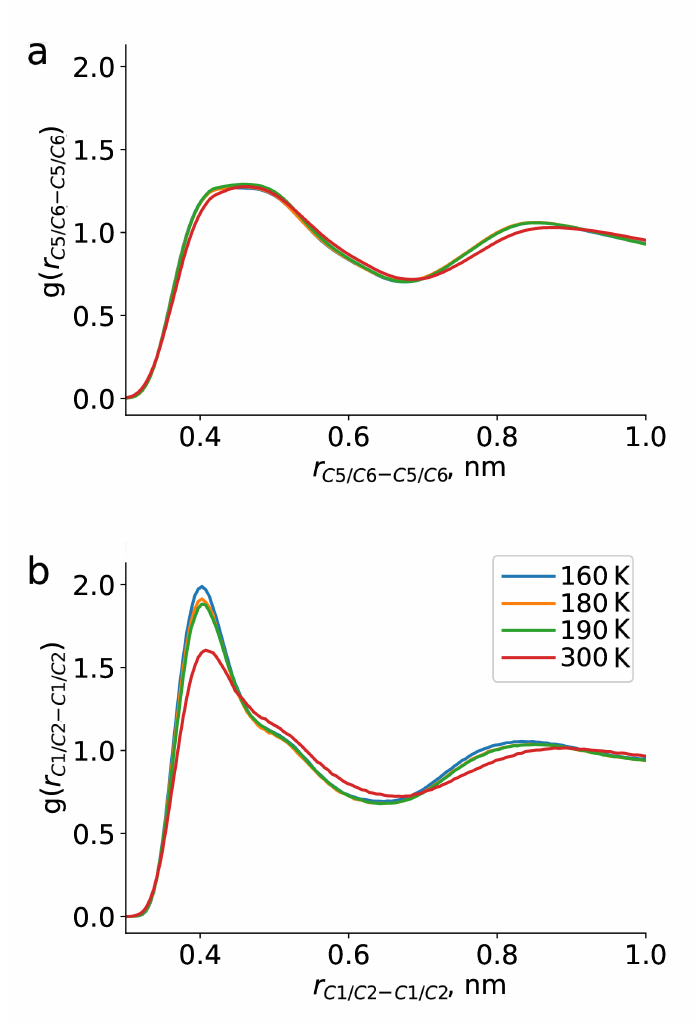
Figure 6. Radial distribution functions for distance between DBP rings (C5 and C6 atoms in Figure 1;